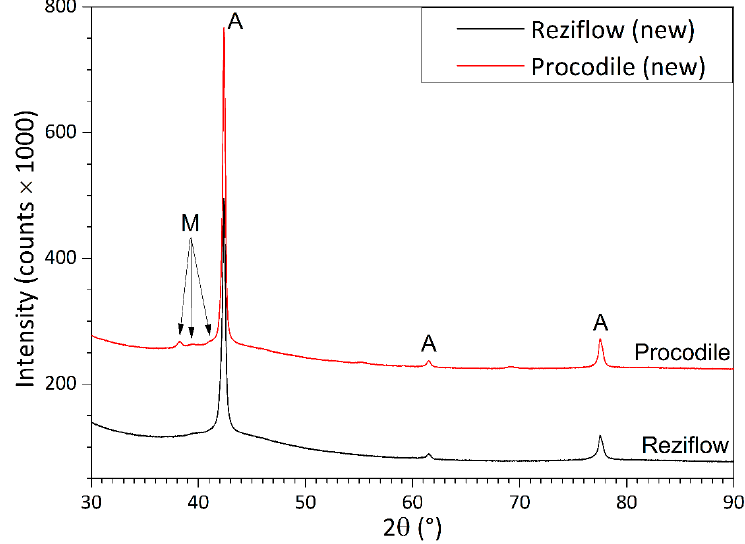
Figure 7. X-ray di ff raction (XRD) patterns acquired on the polished longitudinal sections of the Procodile and Reziflow files. Legend: A = austenite (JCPDF 18-899), M = martensite (JCPDF 35-1281).